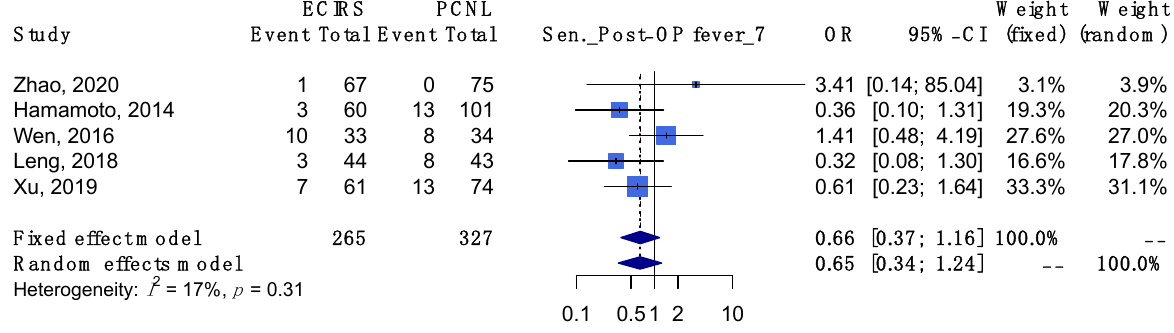
Figure A24. Sensitivity analysis of outcome regarding hemoglobin drop. ([18,19,22,23]) Figure A25. Sensitivity analysis of outcome regarding required blood transfusion. ([17–19,22,23])